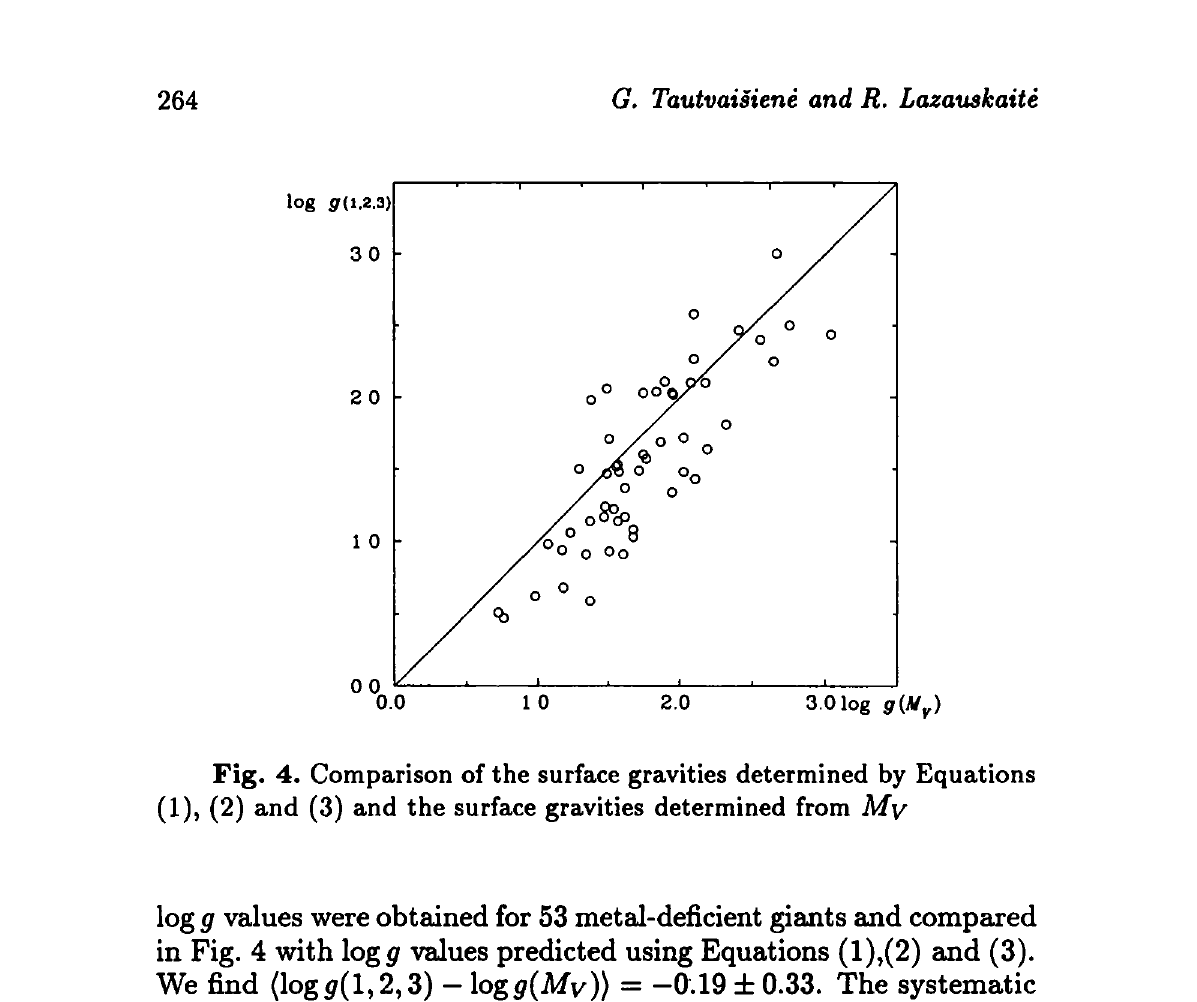
Fig. 4. Comparison of the surface gravities determined by Equations (1), (2) and (3) and the surface gravities determined from